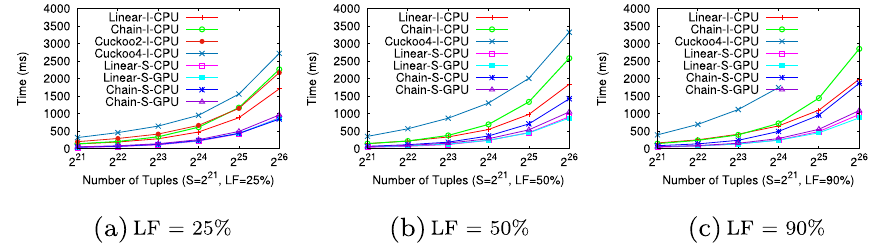
Fig. 9 Performance as the number of tuples changes with different load factors when the number of groups is set at 2 21 * LF with the hash table size of 2 21